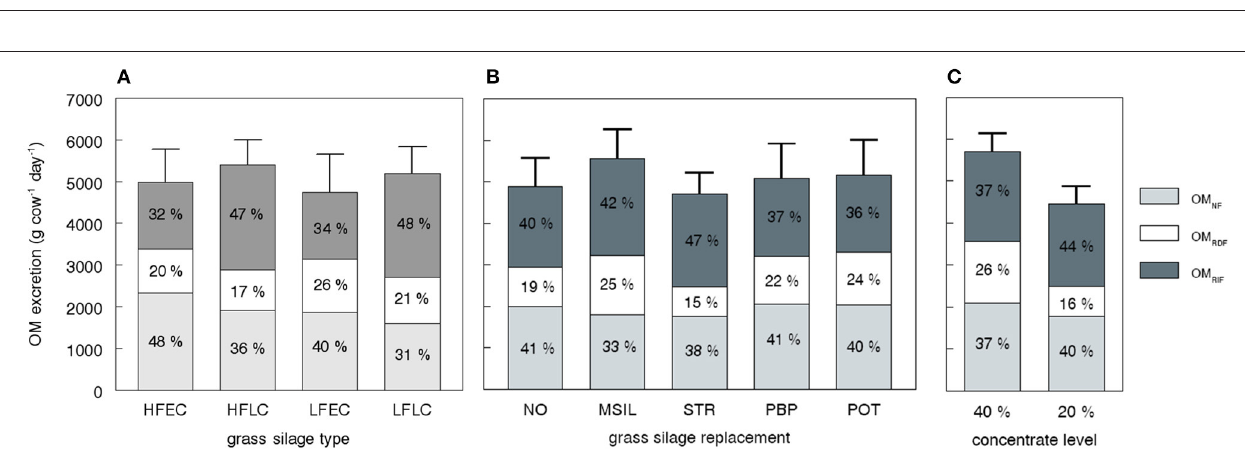
FIGURE 2 | Simulated N excretion divided in three different fractions as affected by nutritional strategy, the carbon (C) to nitrogen (N) (C:N) ratio of these fractions and the C:N ratio of the total excreta. The excreta fractions represent N M (immediately available N), N E (easily decomposable N), and N R (resistant N) as described in Table 6 . The bars represent average values for all strategies with a given grass silage type ( A , n = 10), grass silage replacement ( B , n = 8), and concentrate level ( C , n = 20), as described in Table 3 . HFEC, high fertilized, early cutting stage grass silage; HFLC, high fertilized, late cutting stage grass silage; LFEC, low fertilized, early cutting stage grass silage; LFLC, low fertilized, late cutting stage grass silage; NO, no replacement of grass silage; MSIL, maize silage; STR, straw; PBP, pressed beet pulp; POT, potatoes.